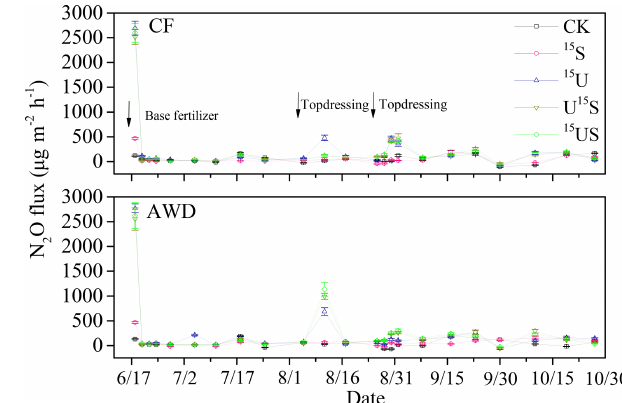
Figure 1. Effects of different treatments on nitrous oxide (N 2 O) flux. Bars represent standard errors ( n = 3), the same below.